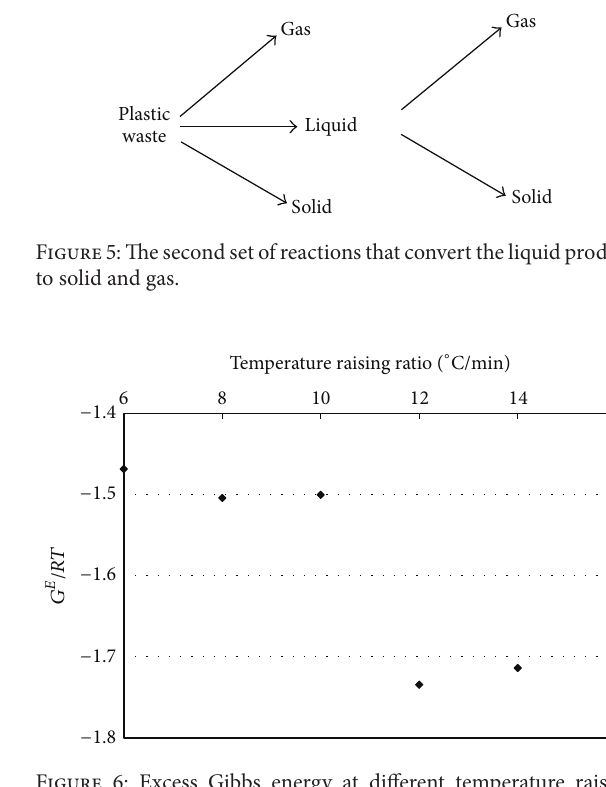
Figure 6: Excess Gibbs energy at different temperature raising ratios. Table 4: Calculated binary interaction parameters for minimizing the RMSD objective